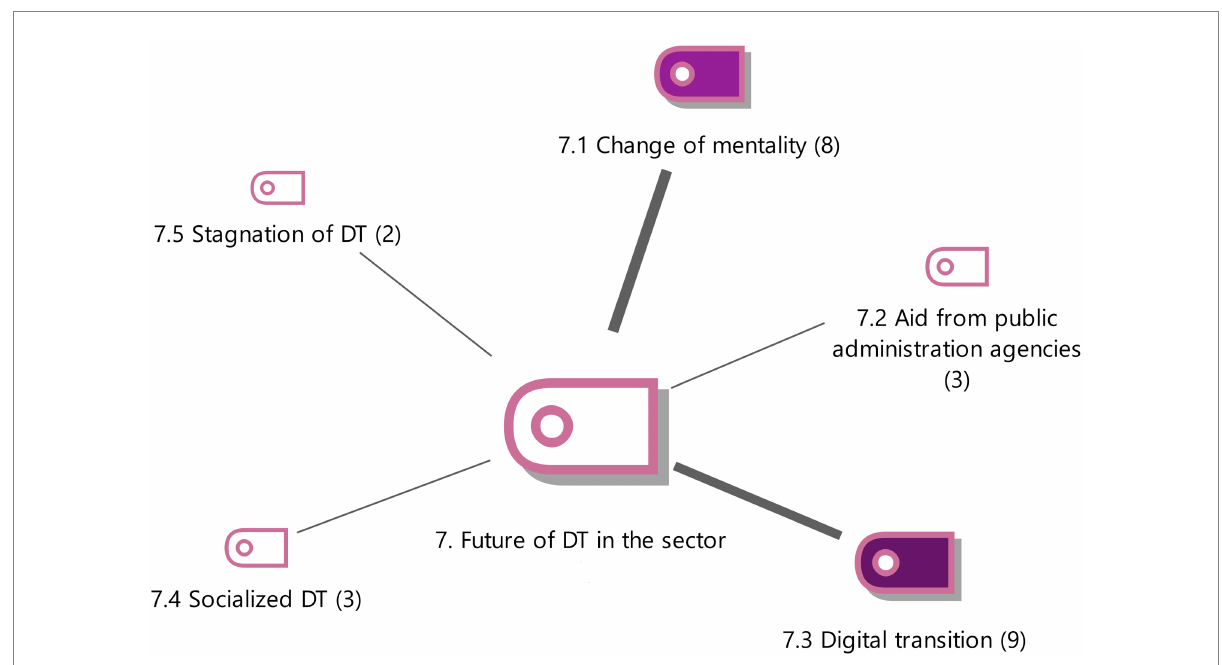
FIGURE 7 Future of DT in the sector with the weighting of the properties Source: Authors